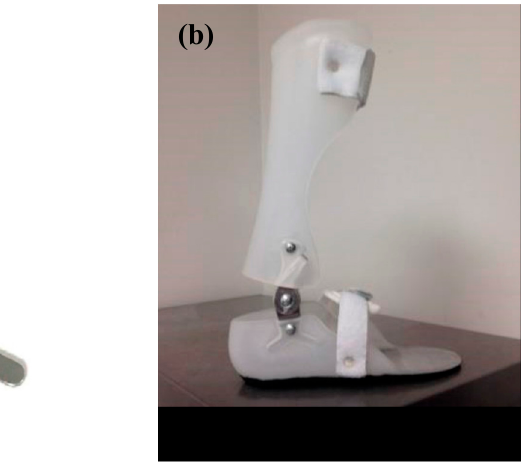
Figure 26. ( a ) Designed superelastic hinge AFO and ( b ) AFO porotype [54].